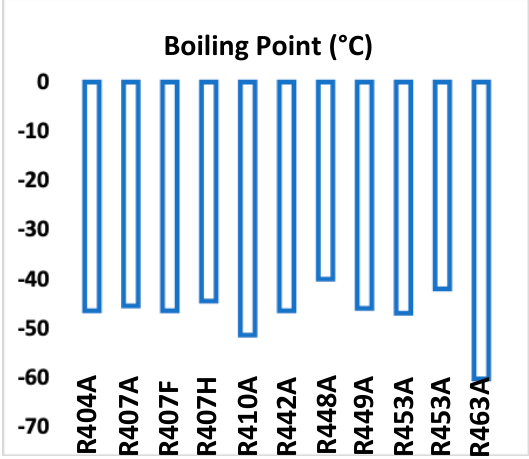
Figure 8. Normal boiling point of all refrigerants.